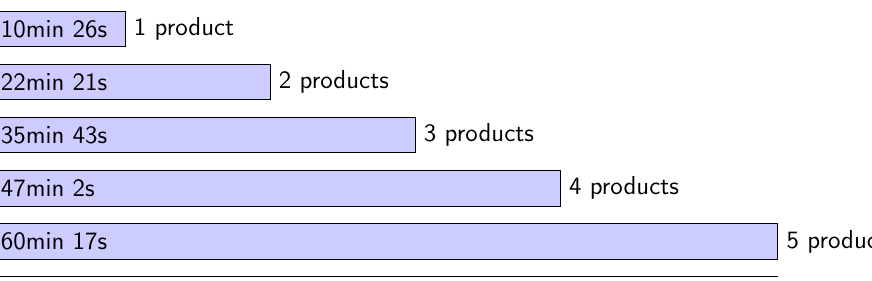
Figure 7. Comparison of answer times for multiple products.